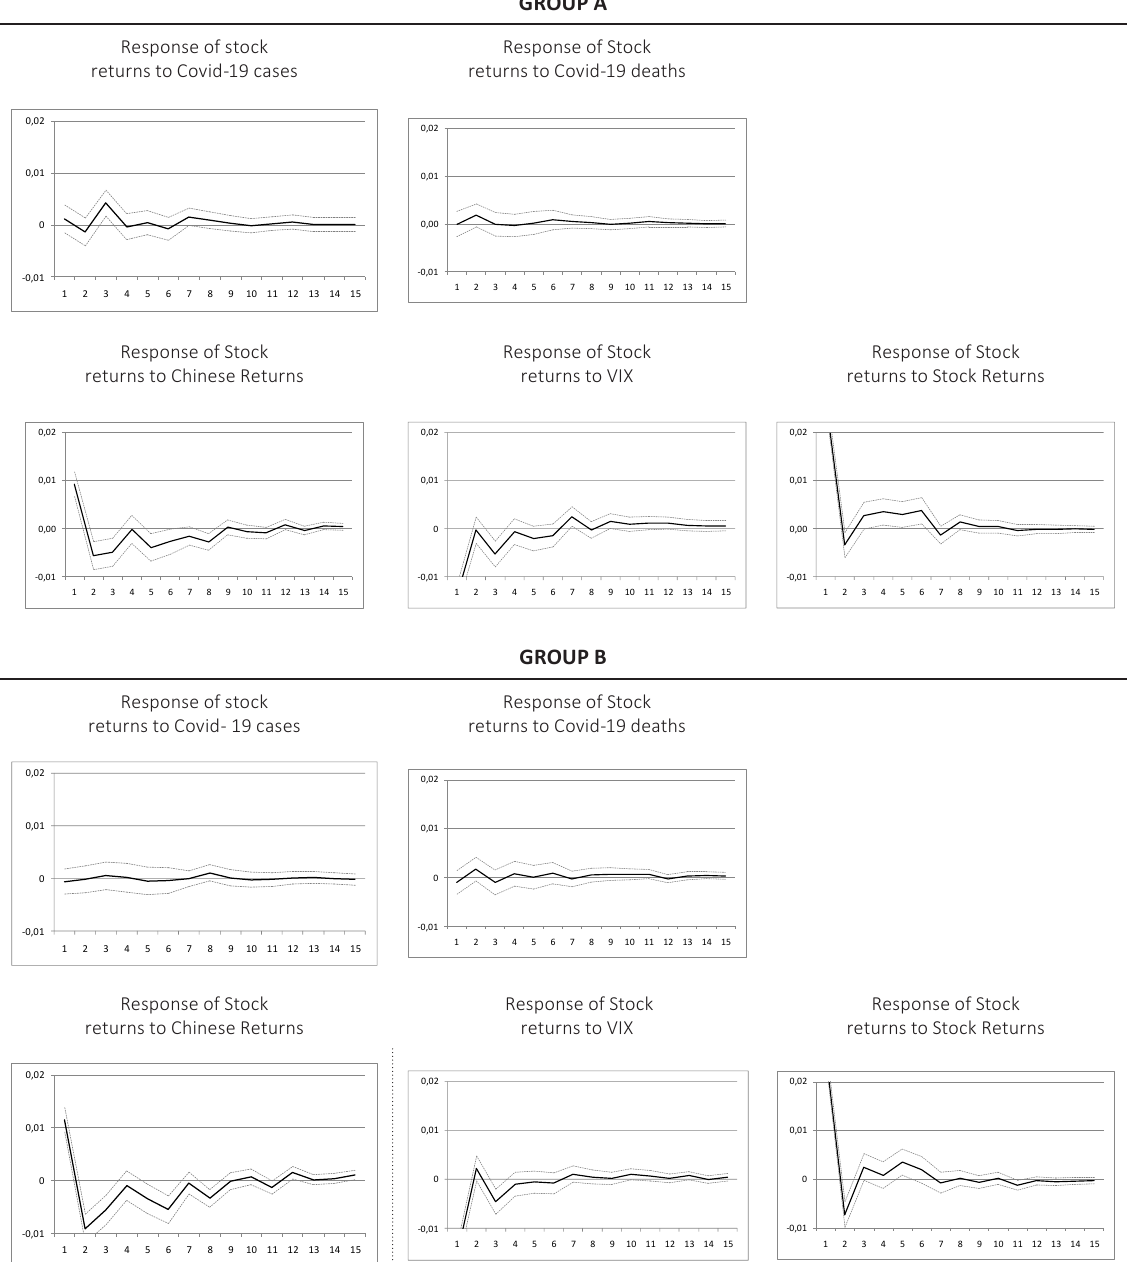
Figure 5. Generalized impulse response of European stock returns to COVID-19 cases and deaths, Chinese returns and VIX index per